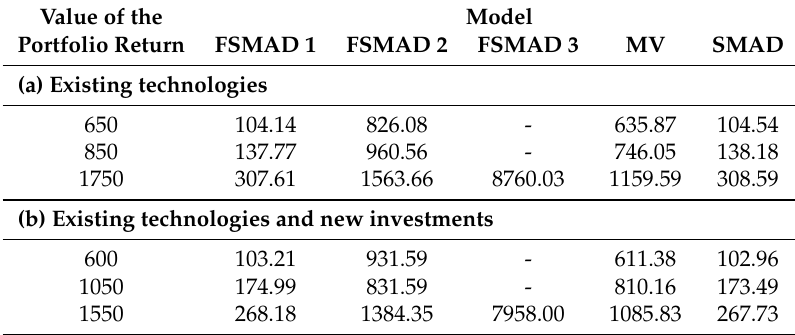
Table 2. Risk values for all models for selected portfolio returns, doubled variance [both in e